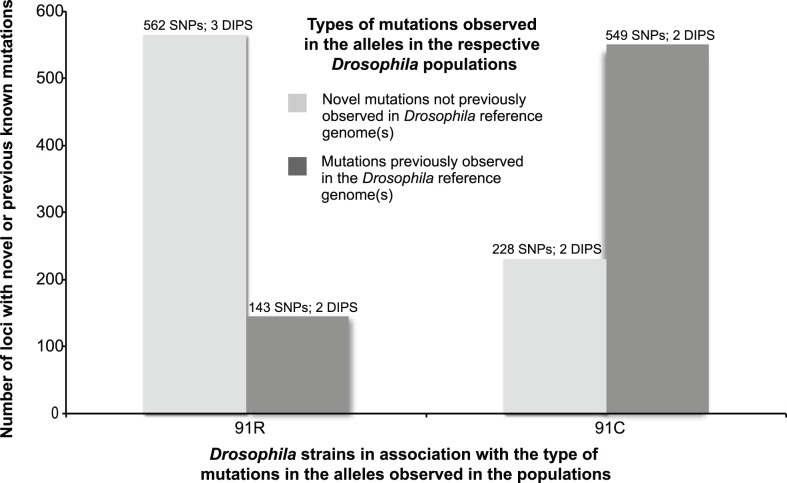
A comparison of allele fixation for the Drosophila melanogaster (Drosophila) fly lines 91-R and 91-C, in their respective populations, in relation to novel and previously known mutations.The figure represents only those mutations observed in the 91-R and 91-C genomes that caused amino acid structural changes in open reading frames (ORFs) resulting from a single nucleotide polymorphisms (SNPs) or deletion/insertion polymorphisms (DIPs). A graphical representation of allele fixation for both 91-R and 91-C across the entire Drosophila genome from each of the two respective populations.